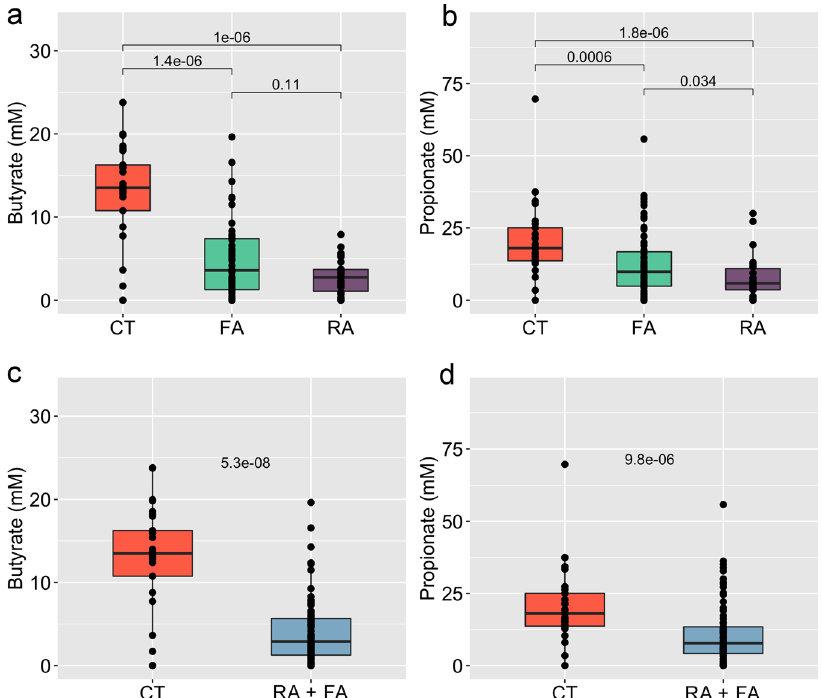
Fig. 2 Short-chain fatty acids are depleted in the gut of allergic children. Box plots showing the concentration of butyrate ( a , c ) and propionate ( b , d ) in faecal samples of allergic and healthy children. Allergic children are included in a unique group ( c , d ) or separated according to the type of allergy ( a , b ). The signi fi cance was tested by applying pairwise Wilcoxon test. Data are obtained from n = 29, 55 and 30 biologically independent samples for CT (healthy controls), FA (food allergy) and RA (respiratory allergy), respectively. Boxes represent the interquartile range (IQR) between the fi rst and third quartiles, and the line inside represents the median (2nd quartile). Whiskers denote the lowest and the highest values within 1.5 x IQR from the fi rst and third quartiles,